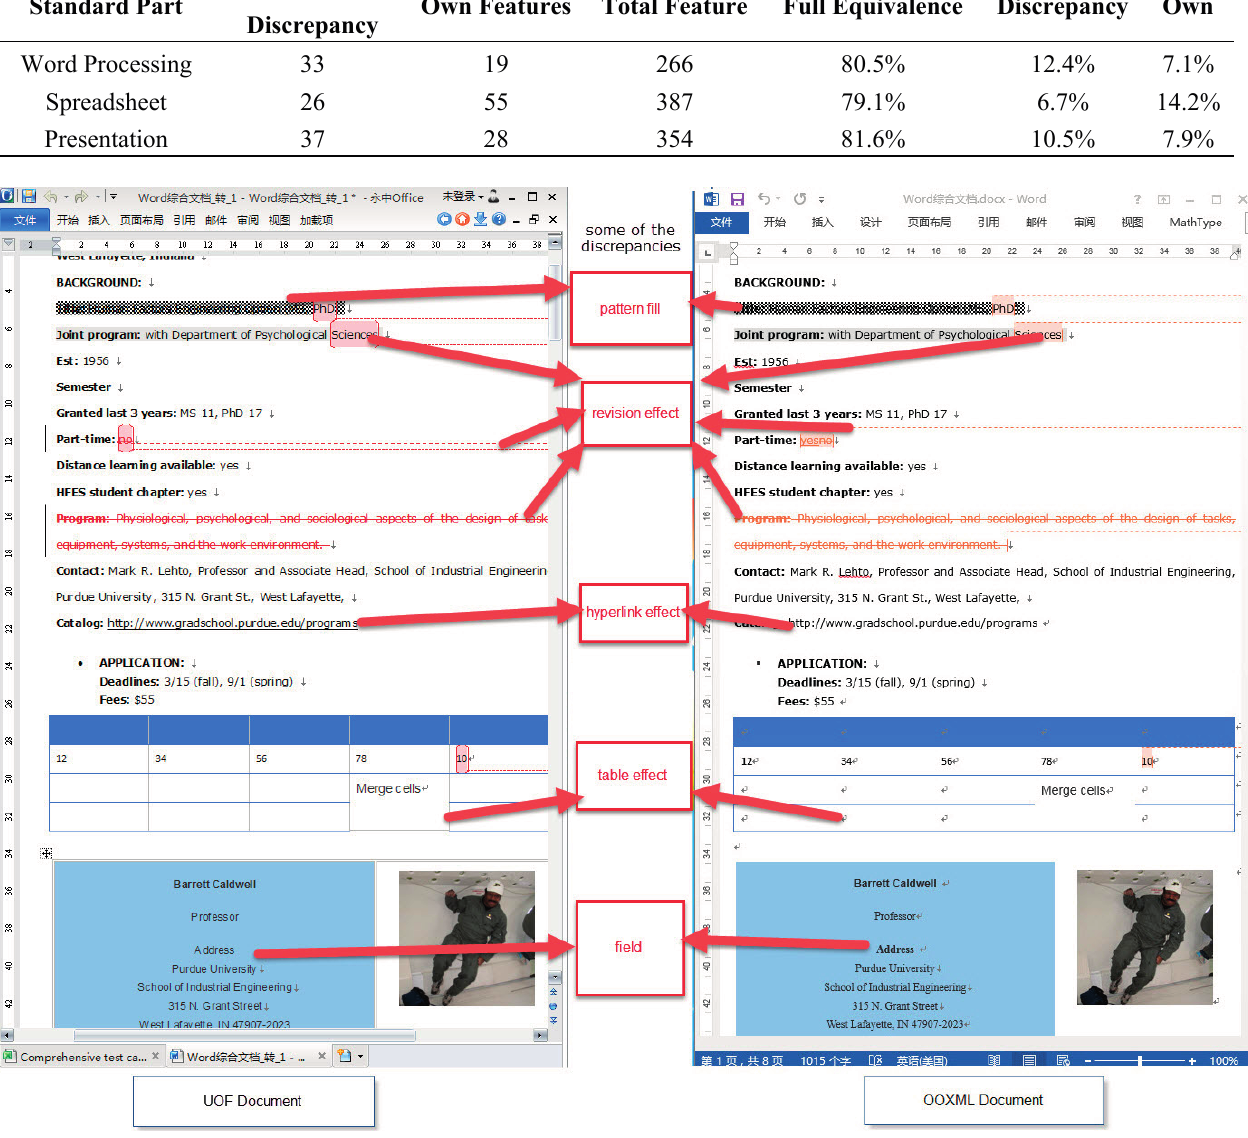
Figure 1. Word Processing